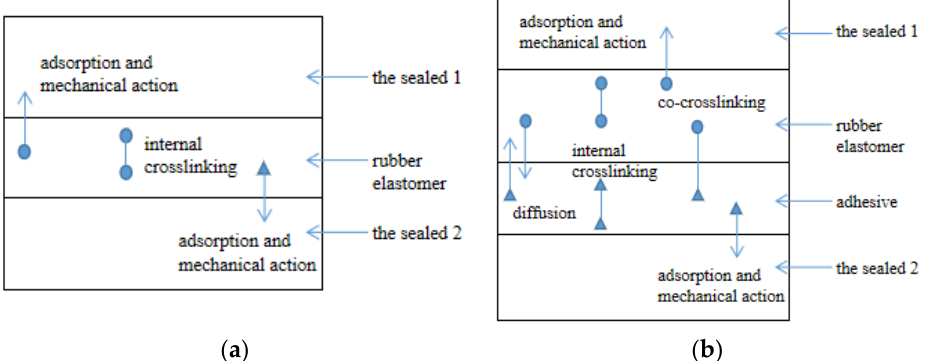
Figure 3. Schematics of the adhesion mechanism of: ( a ) adhesive static sealing without adhesive; ( b ) adhesive static sealing with adhesive.